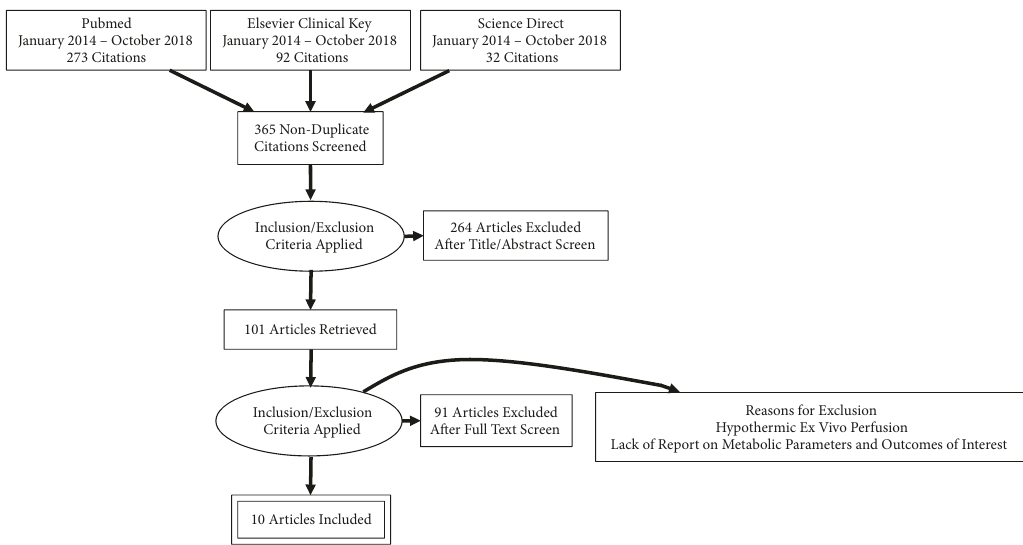
Figure 1: Data selection flow